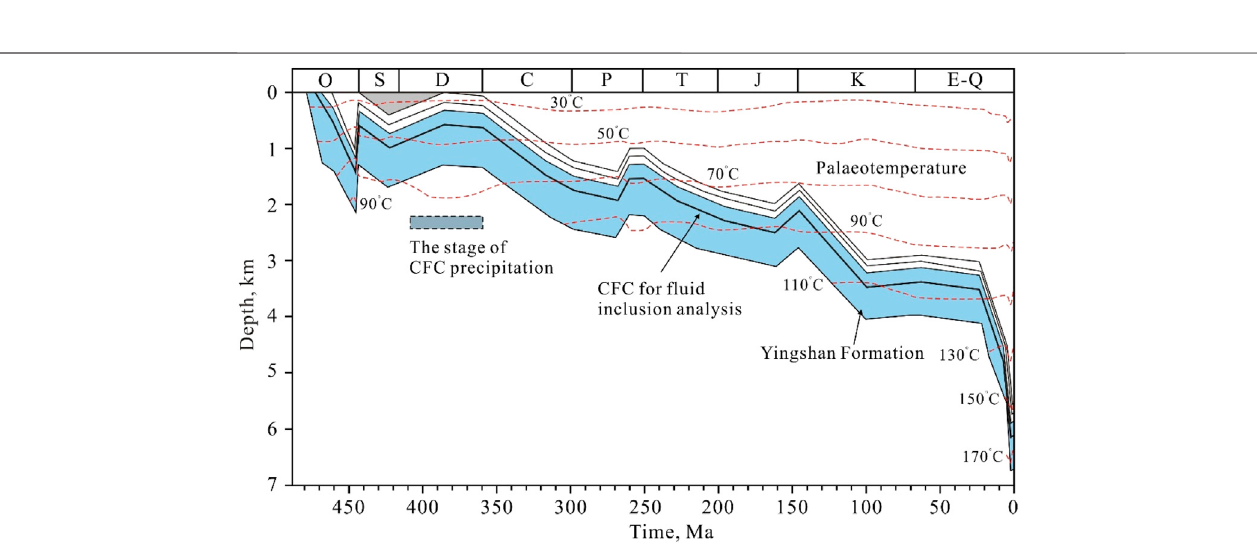
Frontiers in Earth Science |